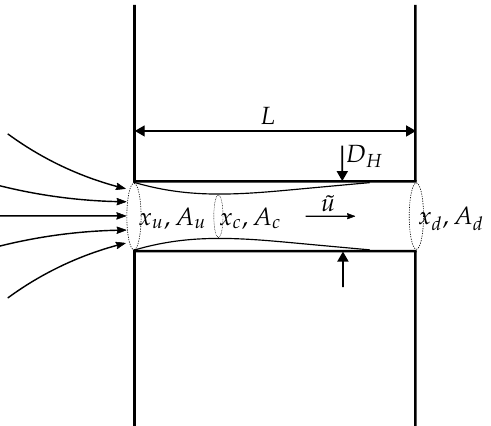
Figure 1. Contracting and expanding flow in a long